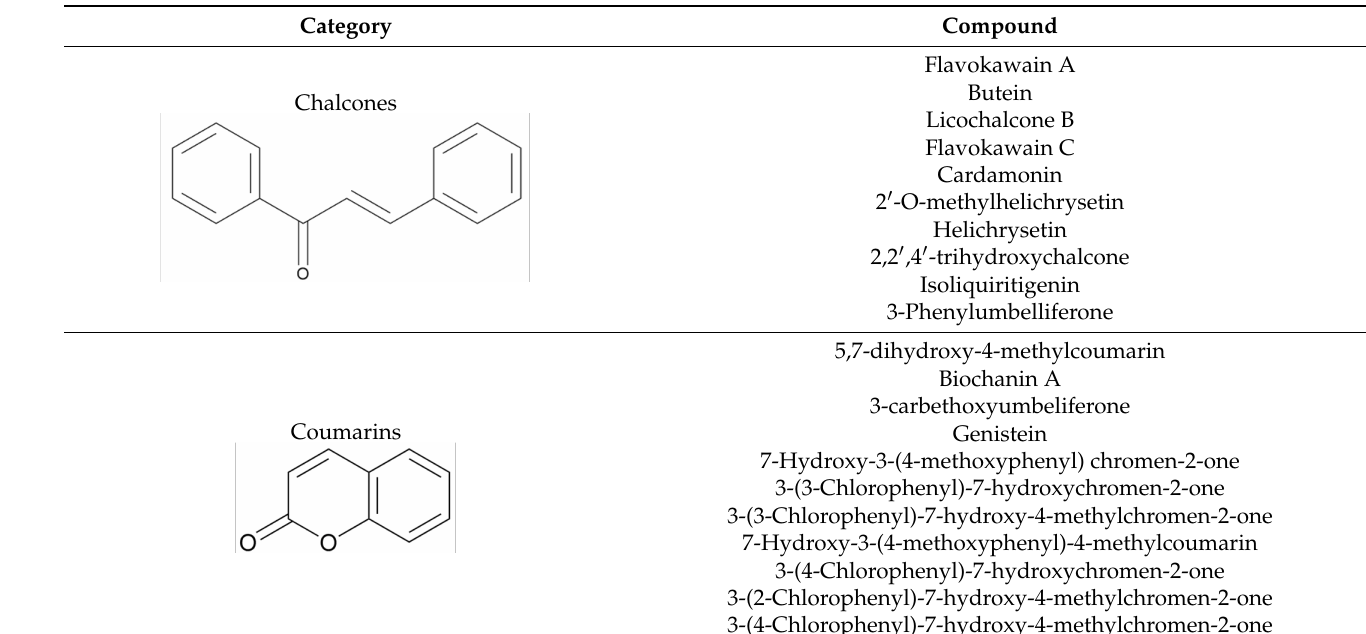
Table 1. Screening results